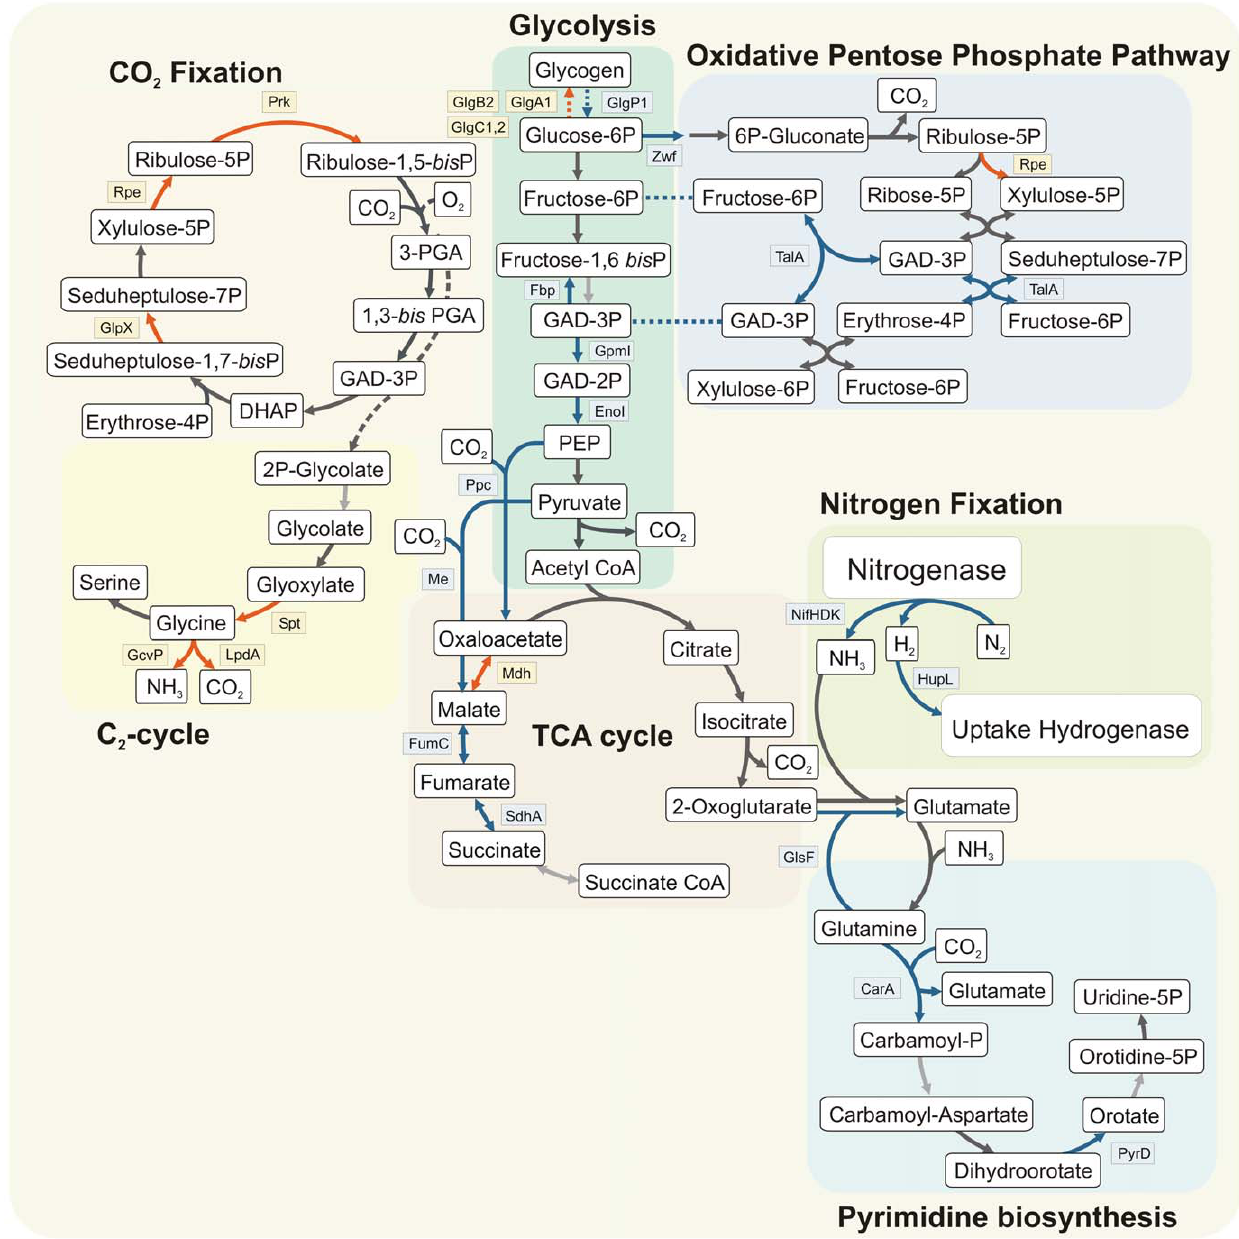
Figure 5. Overview of diurnal changes in the abundance of proteins involved in central metabolic pathways during a circadian cycle. Enzymatic steps involving proteins with maximal abundance during the dark are shown in blue , while proteins with peak expression during the light period are represented by red arrows. Dark grey colored arrows indicate proteins without significant changes in their abundance during a diurnal period while light grey colored arrows represent proteins that were not detected. GlgA1: glycogen synthase, GlgB2: 1,4-alpha-glucan branching enzyme, GlgC1,2: glucose-1-phosphate adenylyltransferase, GlgP1: glycogen phosphorylase, Zwf: glucose-6-phosphate dehydrogenase, TalA: transaldolase AB family, Fbp: fructose 1,6 bisphosphatase I, GpmI: 2,3-bisphosphoglycerate-independent phosphoglycerate mutase, EnoI: Enolase, Ppc: Phosphoenolpyruvate carboxylase, Me: malic oxidoreductase, Mdh: Malate dehydrogenase, FumC: fumarate hydratase, SdhA: succinate dehydrogenase subunit A, NifHDK nitrogenase subunits HDK, HupL: uptake hydrogenase large subunit, GlsF: ferredoxin-dependent glutamate synthase, CarA: carbamoyl phosphate synthase, PyrD: dihydroorotate dehydrogenase, Prk: phosphoribulokinase, Rpe: ribulose-phosphate 3- epimerase, GlpX: fructose-1,6-bisphosphatase II, Spt: serine:pyruvate/alanine:glyoxylate aminotransferase, GcvP: glycine carboxylase, LpdA: dihydrolipoamide dehydrogenase, 3-PGA: 3-phosphoglycerate, 1,3-bis PGA: 1,3 bis -phosphoglycerate, GAD-3P: glyceraldehyde-3-phosphate, DHAP: dihydroxy acetone phosphate.